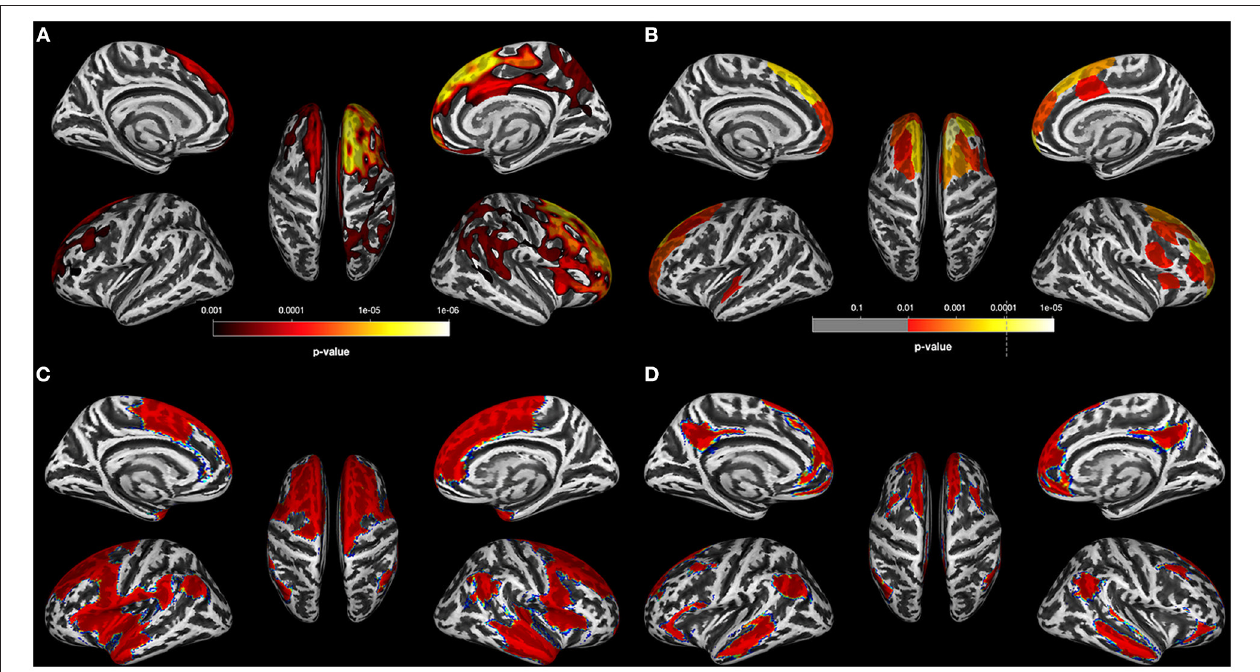
FIGURE 1 | Results for AUD individuals (A) . Results of the data-driven vertex-wise cortical thickness (CT) analysis—controls have significantly higher CT values than alcohol use disorder individuals (AUD) at p = 0.001 FWE corr. (TFCE). (B) Results of the data-driven ROI analysis with the Schaefer Atlas (48) (200 parcels) colored are ROIs for which controls have significantly higher mean CT values than AUD at p = 0.01 FDR corr; (C) CT covariance results highlighted with red color all Schaefer ROIs with which the two ROIs corresponding to the two peak vertices of the most significant clusters in (A) show significant positive correlations at p < 0.05. (D) Result of the Neurosynth seed correlation analysis (thresholded at r > 0.2) with resting-state data of 1,000 healthy participants with the MNI coordinates of the two peak vertices of the most significant clusters in (A) as